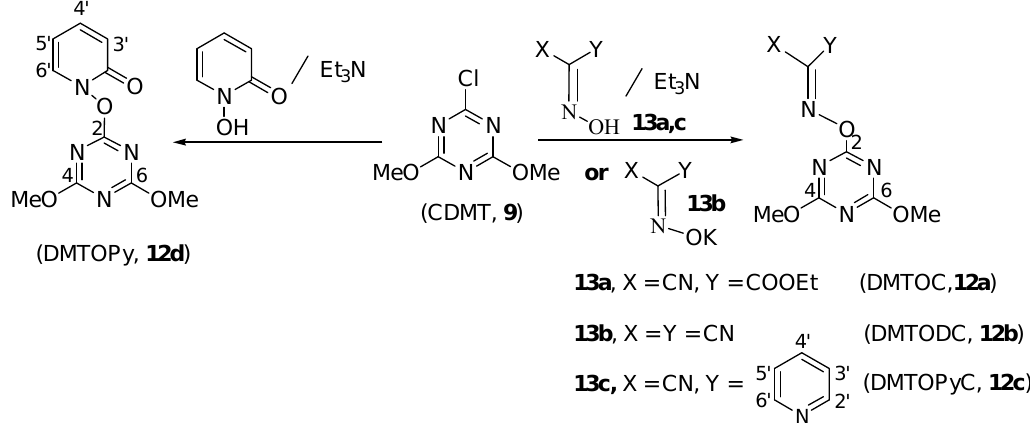
Scheme 1. Synthesis of triazinyloxyimino